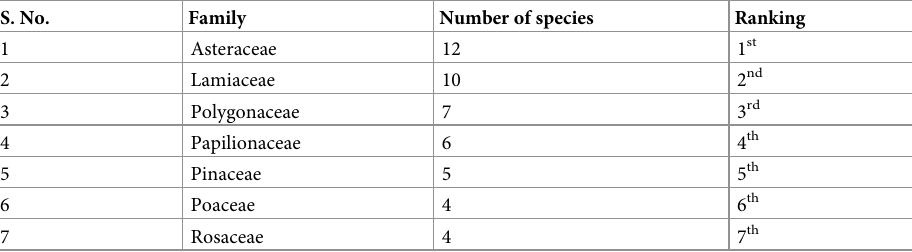
Table 6. Family index in study area of two villages Dawarian and Ratti Gali of AJK, Pakistan. S. No.